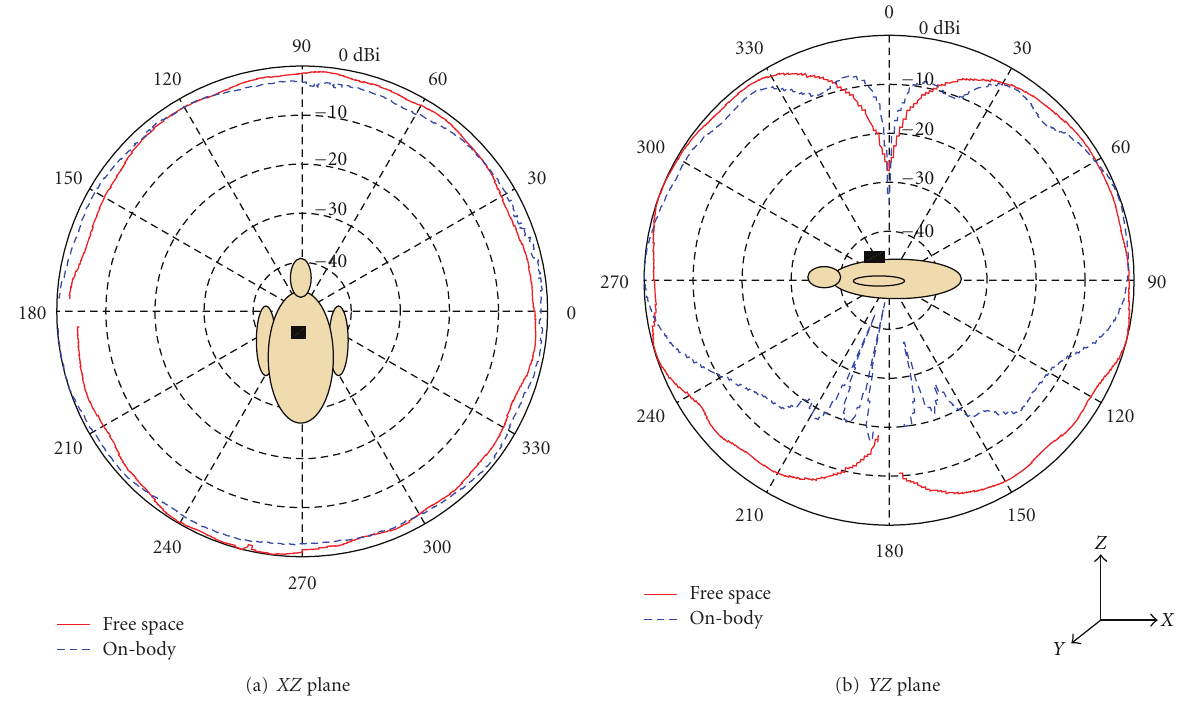
Figure 3: Measured free space and on-body radiation patterns at 6.6GHz of the tags (a) XZ plane and (b) YZ plane.